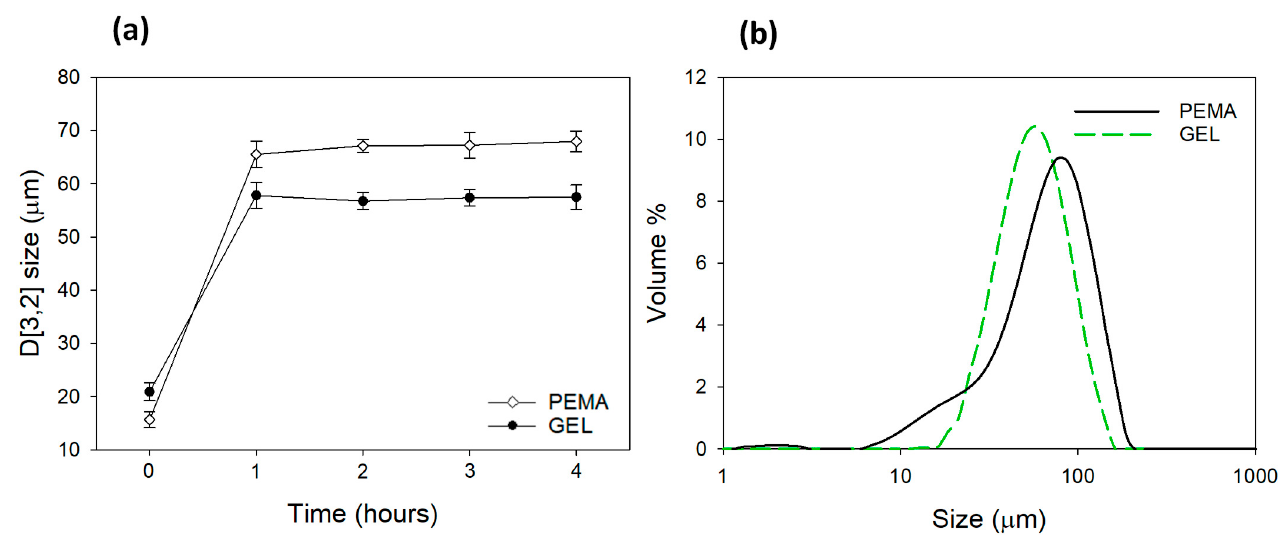
Figure 6. ( a ) The in situ reaction monitoring of the particle sizes (D[3,2]) over a 4 h period for microcapsules produced with PEMA and GEL emulsifiers ( b ) the final size distribution for the microcapsules formulated with PEMA and GEL emulsifier after the complete reaction.